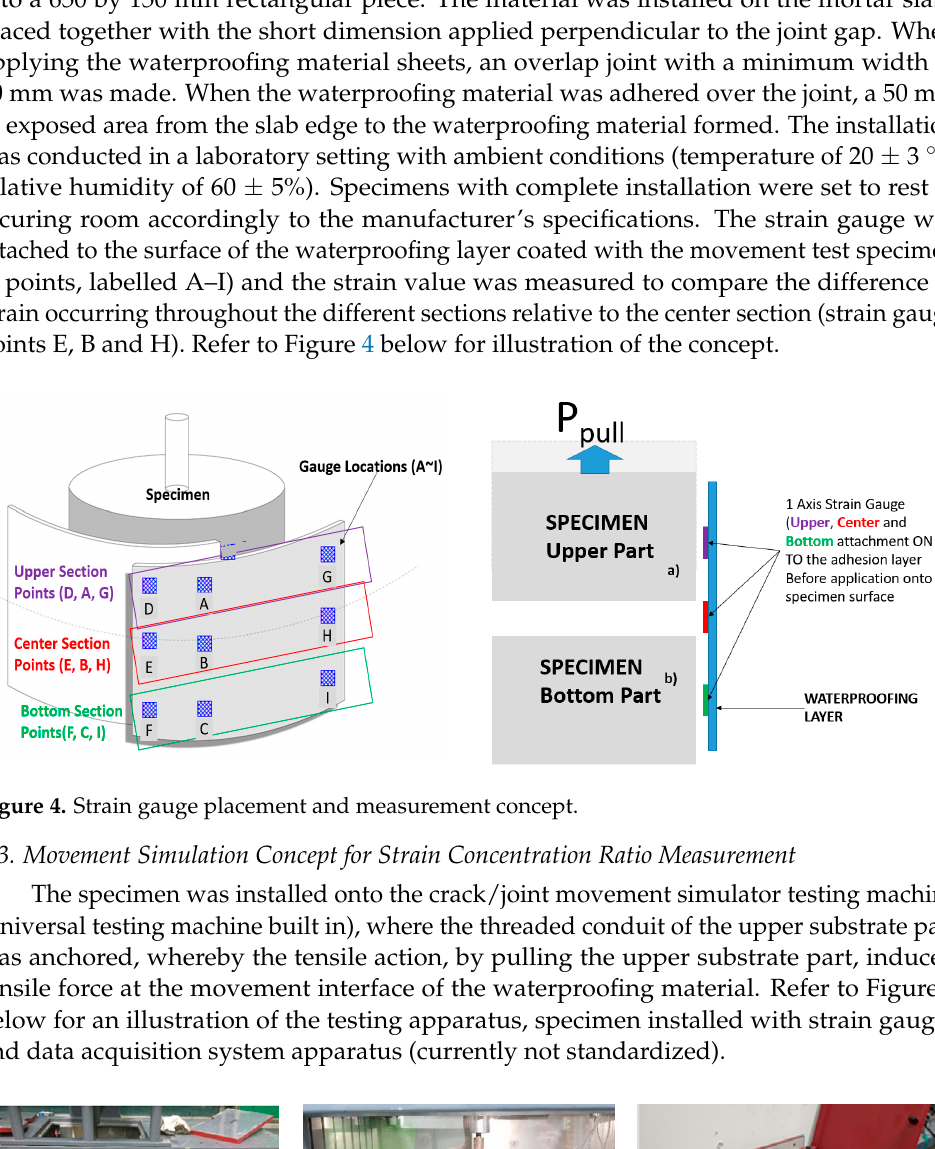
Figure 3. Movement simulation specimen for strain concentration ratio evaluation.